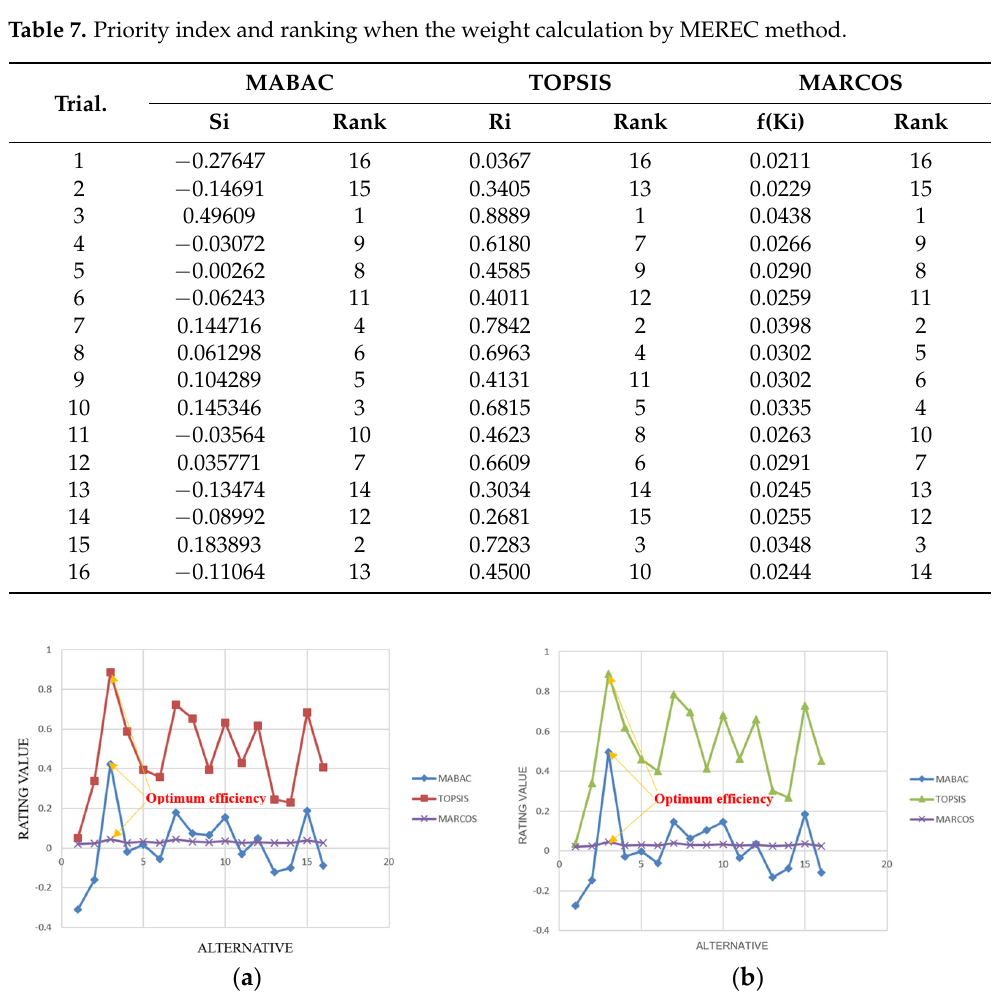
12 Table 7. Priority index and ranking when the weight calculation by MEREC method. Trial.